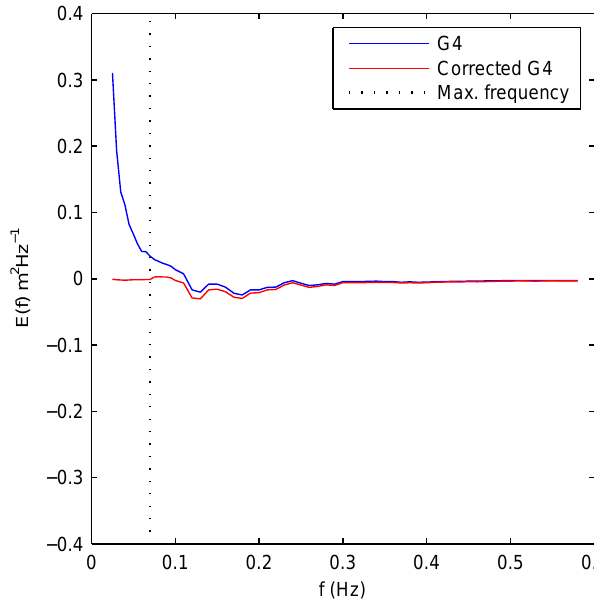
Figure 5. Bias of the power spectrum of the G4 data before and after the correction compared to the reference data from the DWR. The distribution is based on 3 weeks of